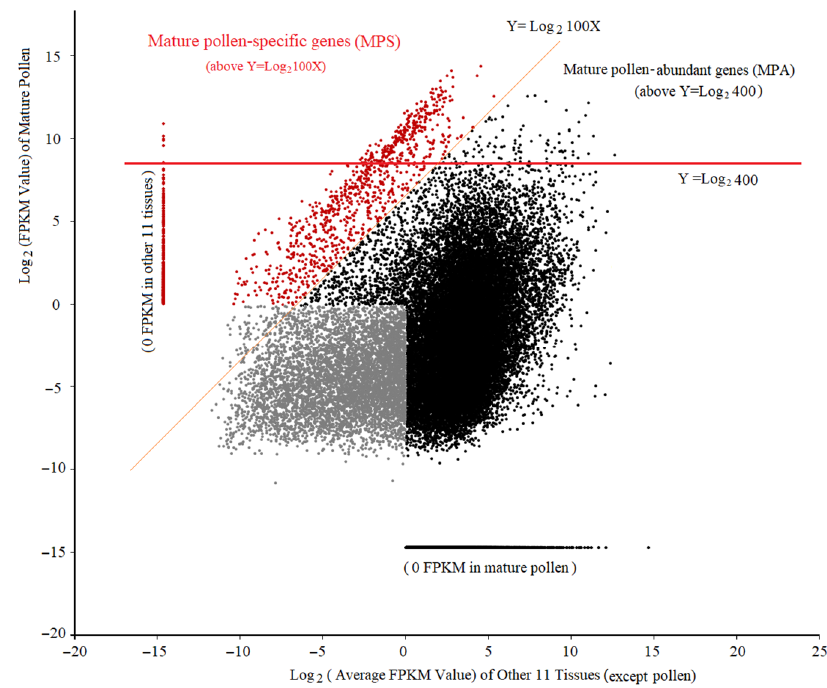
Figure 2. Two-dimension scatter plot of transcript abundance in mature pollen vs. the mean of other 11 tissues. The x -axis indicates the average of transcript abundances in the other 11 tissues (except pollen) and the y -axis indicates the transcript abundance detected in mature pollen [69] with each point representing a unique gene model. Mature pollen-specific genes (MPS) are distributed above the orange line ( y = log 2 100x) and mature pollen-abundant genes (MPA) are located above the red line ( y = log 2 400). Red points represent all MPS and the grey points represent the trace-expressed genes in all